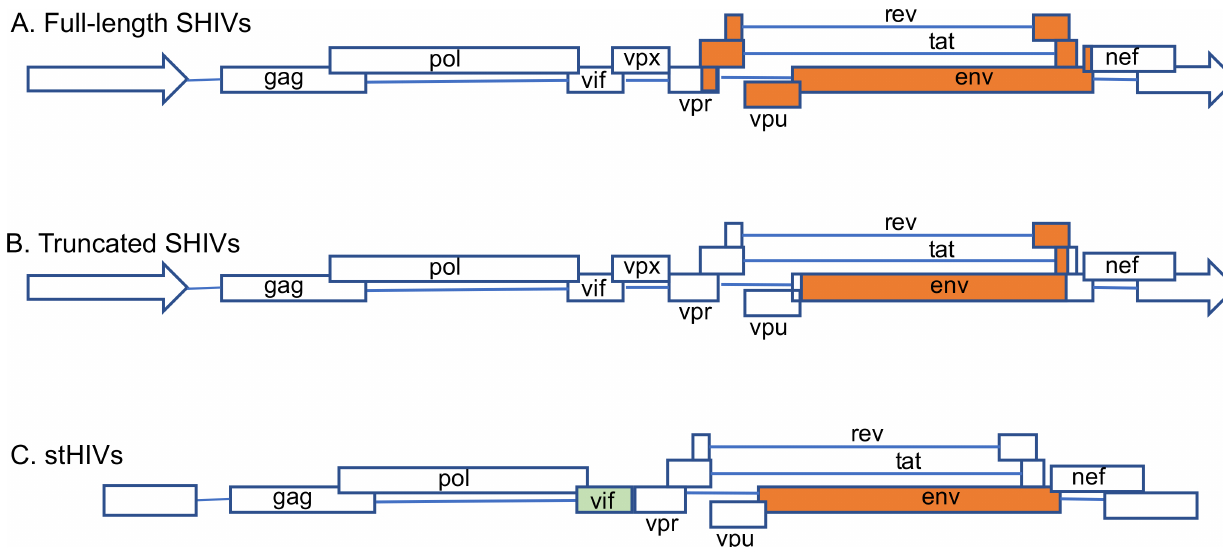
Fig 2. Genomic organization depicting portions of env used in the construction of (A) SHIVs with full length clade C HIV Zambian T/F env genes (B) SHIVs with truncated env genes and (C) stHIV, where vif of HIV molecular clones were replaced by SIV mac239 vif .